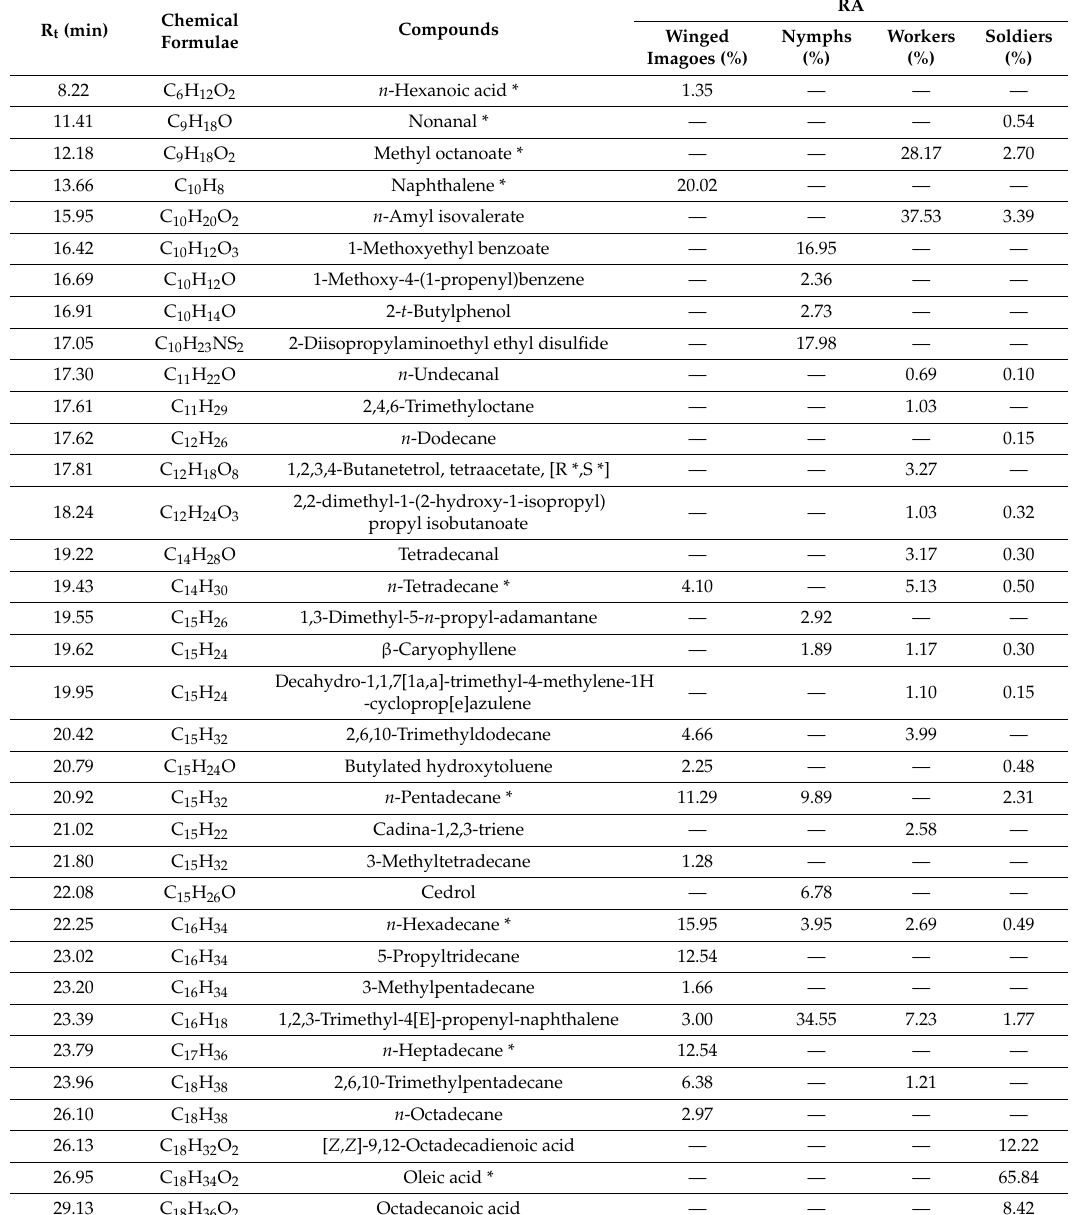
Table 1. Volatile organic compound profiles of Coptotermes formosanus